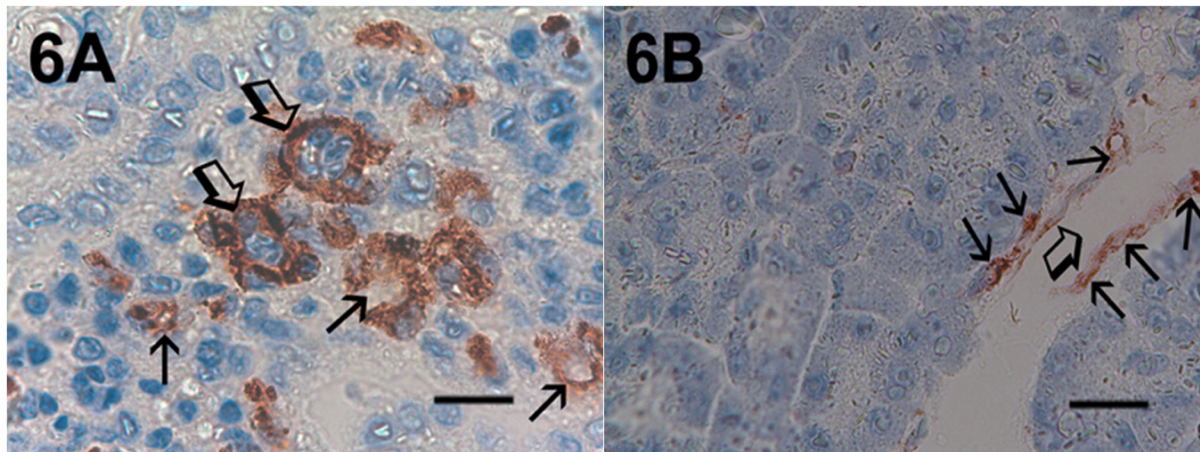
Figure 6. Magnification × 1000 in oil, 0.06 mm 2 area, immunostaining with the anti-CD31 antibody. ( A ) High MVD in primary PDAT section. Small arrows indicate single red-stained microvessels. Big arrows indicate single microvessels with tumour cells in their lumen. ( B ) Low MVD in ANT section. Small arrows indicate immunostained endothelium of a large vessel; the big arrow indicates the lumen of the vessel. Scale bar corresponds to 150 µ m.